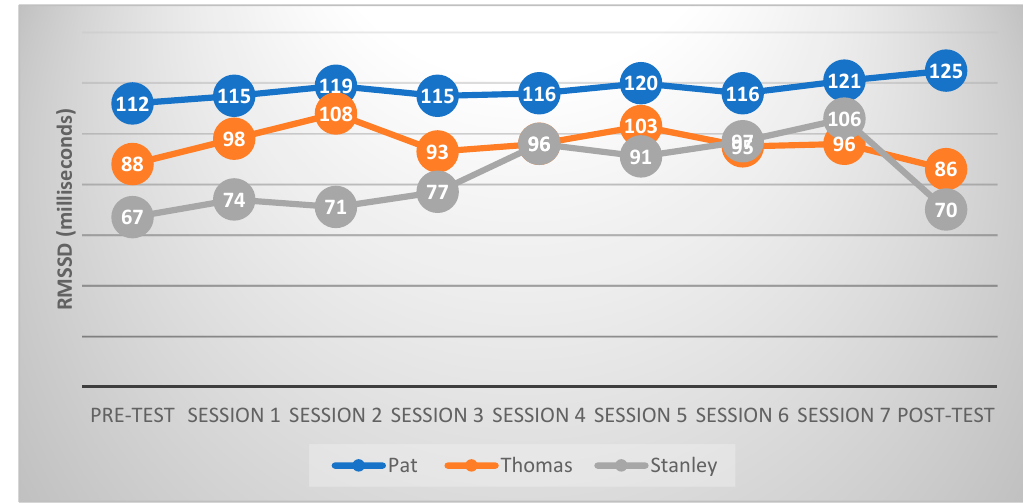
Figure 4. The RMSSD, heart rate variability (HRV) measures, of the three third-graders in the pre-test, during the intervention and in the post-test.